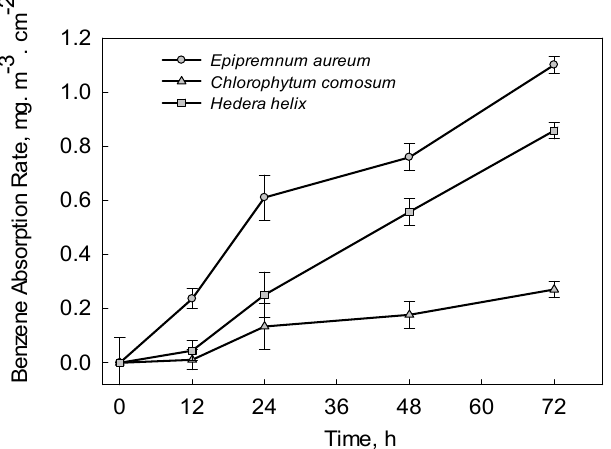
Figure 3. Benzene absorption rate of Epipremnum aureum , Chlorophytum comosum and Hedera helix . The error bar indicates the standard deviation for three replicates.